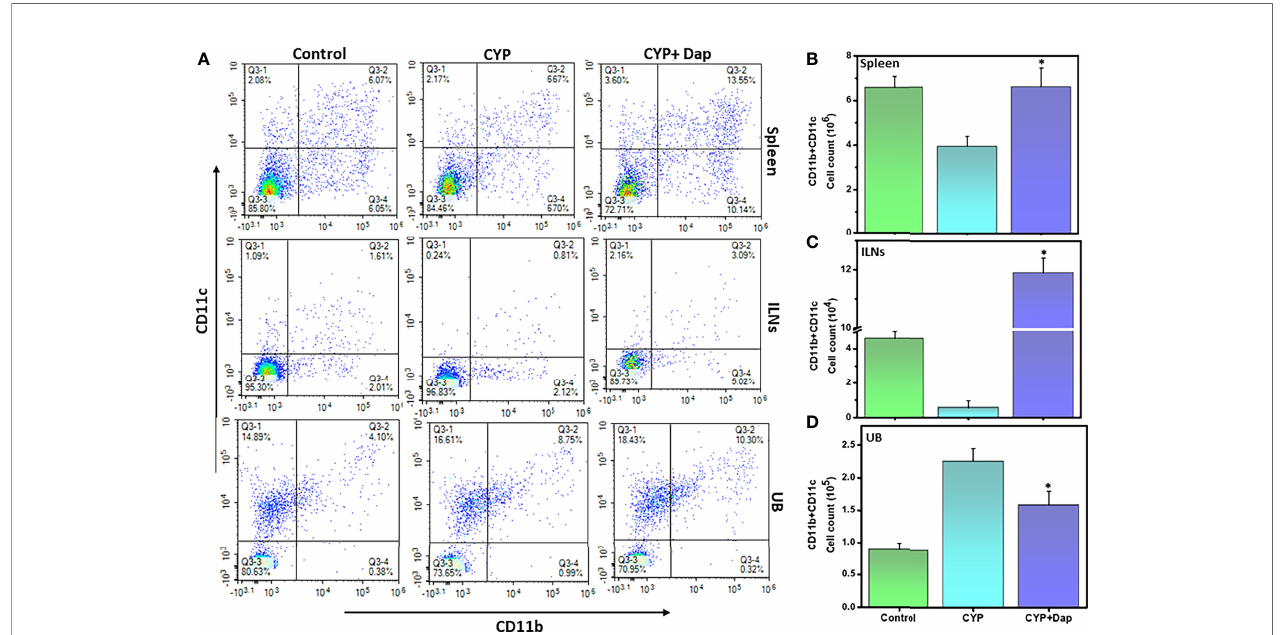
FIGURE 4 | Dap alters dendritic cells (DCs) frequency during IC. Single-cell suspensions from the spleen, ILN, and UB were isolated from the three groups at the experimental endpoint, as described in the legend in Figure 2 . Mean values ± SEM from three independent experiments involving six mice per group (n=18) are shown. Changes in the frequency and expression of DCs (CD11b + CD11c + ) from spleens, ILNs, and UBs cells are shown in (A) , while changes in the number of DCs in the spleen, ILN, and UBs are shown in (B – D) , respectively. The statistical signi fi cance of fl ow cytometry data between the three groups was assessed and asterisks indicate statistically signi fi cant differences between CYP+vehicle and CYP+Dap groups (*p<0.01). Representative data from one of at least three experiments that produced similar results are depicted in the fi